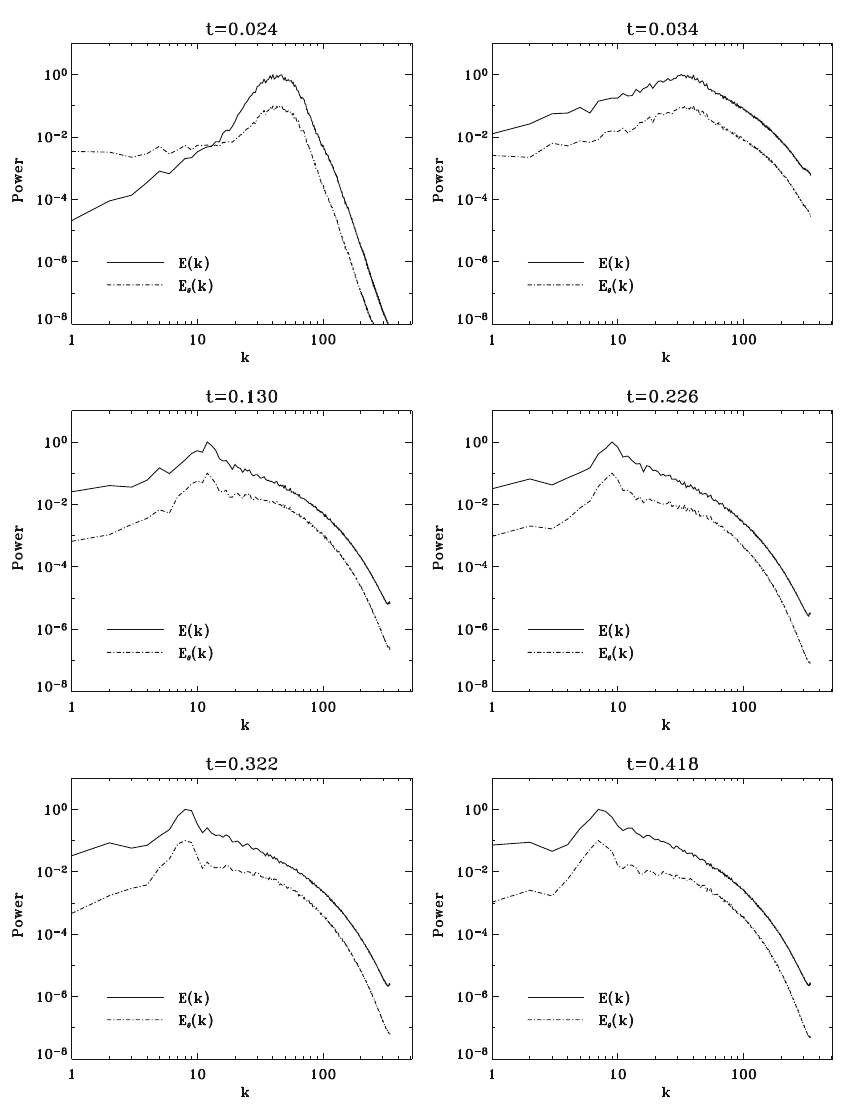
Fig.13 From left to right and top to bottom: dynamical evolution of the spectra of temperature fluctuations E θ ( k ) and kinetic energy fluctuations E ( k ) as a function of time and integer horizontal wave number k and time t (measured in vertical thermal diffusion units) in the large-aspect ratio idealized simulation of turbulent convection with mild density stratification shown in Fig. 12 (left), Ra = 3 × 10 5 and Pr = 0 . 3. k = 1 corresponds to the horizontal size of the domain and k = 42 to the vertical size of the domain. The peak scale of the spectra ( k (cid:6) 7 towards the end of the simulation, much larger than the vertical size of the domain) correspond to the large-scale thermal structures visible in Fig. 12. Image from Rincon (2004), Chap. 4.3, p.